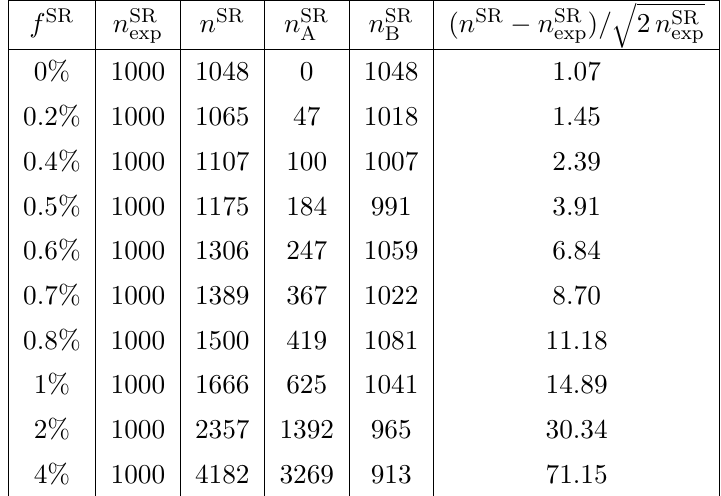
Table 1 . Number of events n SR selected from the signal region for N CR = N SR = 10 6 and several signal fractions f SR . We have used the mean score of five classifiers trained on the same data. We also show the number of events expected to be selected in the absence of a new physics signal, n SR , and the number of selected anomalous and background events ( n SR exp two numbers are not known for real data. The last column shows an estimate of the statistical significance of a possible